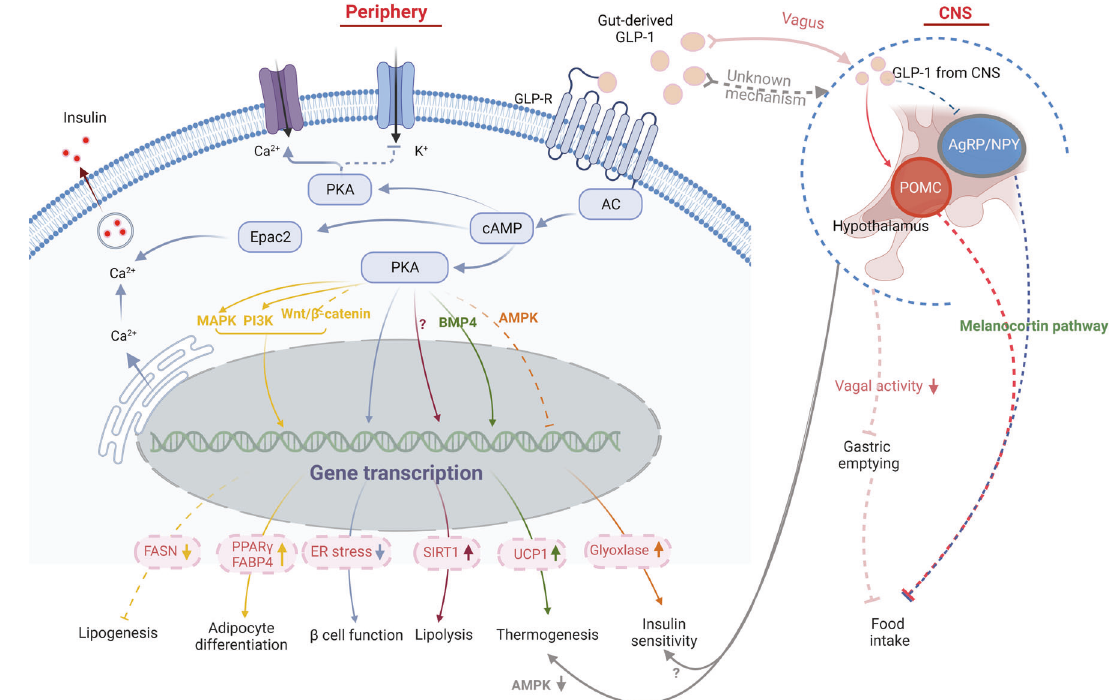
and elevating glyoxalase. By interacting with multiple signaling pathways including PI3K, MAPK, and Wnt4- β -catenin pathways, GLP-1 promotes pre-adipocyte differentiation by up-regulating PPAR γ and FABP4, but suppresses lipogenesis in mature adipocytes by